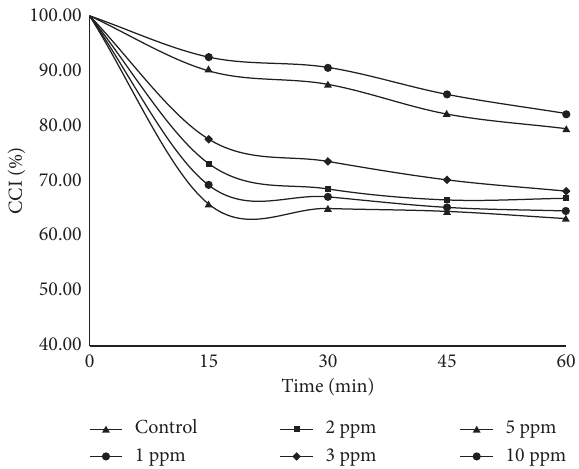
Figure 2: Effect of ATMP concentration on calcium carbonate scale formation changes the legend for 1 mg/L and 10mg/L, as a function of time.